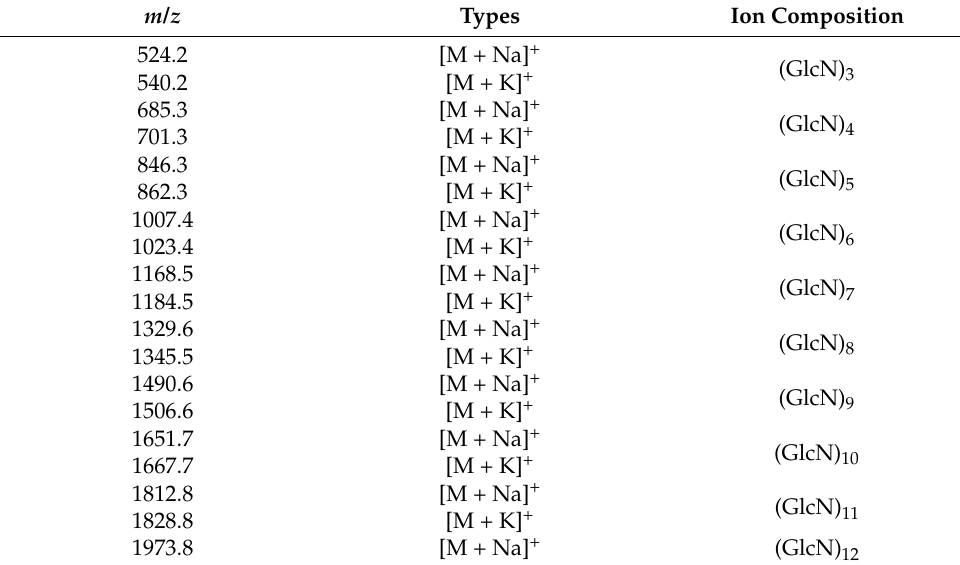
Figure 3. MALDI-TOF-MS of COS BioA187. Table 1. Assigned ion composition of MALDI-TOF-MS spectra of COS